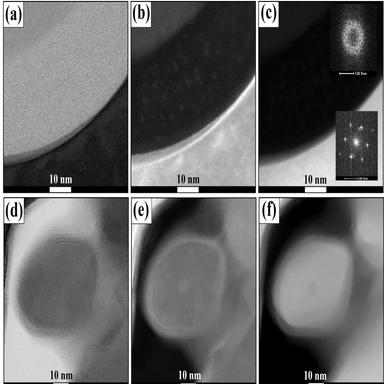
High-resolution microscopy of interfacial bonding between (a-c) alumina and (d-f) complex nanoparticles with the steel matrix: (a, d) BF, (b, e) DF, and (c, f) HAADF TEM images.